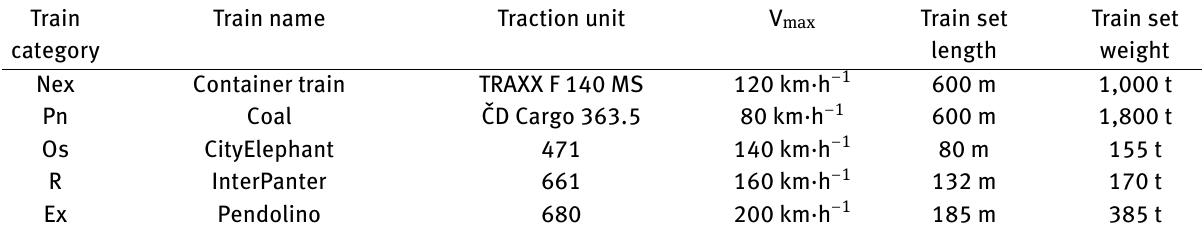
Table 2: Results provided by the headway calculator for one of the sections